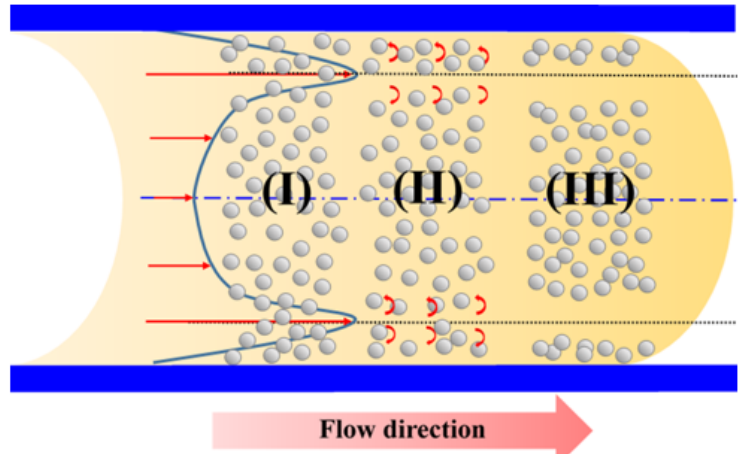
Figure 2. Shear-induced migration of metal powder particles in composite metal injection molding (MIM) material. Region (I): metal powder particles have random distribution within binder matrix; Region (II): metal powder particles rotate in different directions under effects of high shear rate gradient; Region (III): phase separation of metal powder particles and binder material.